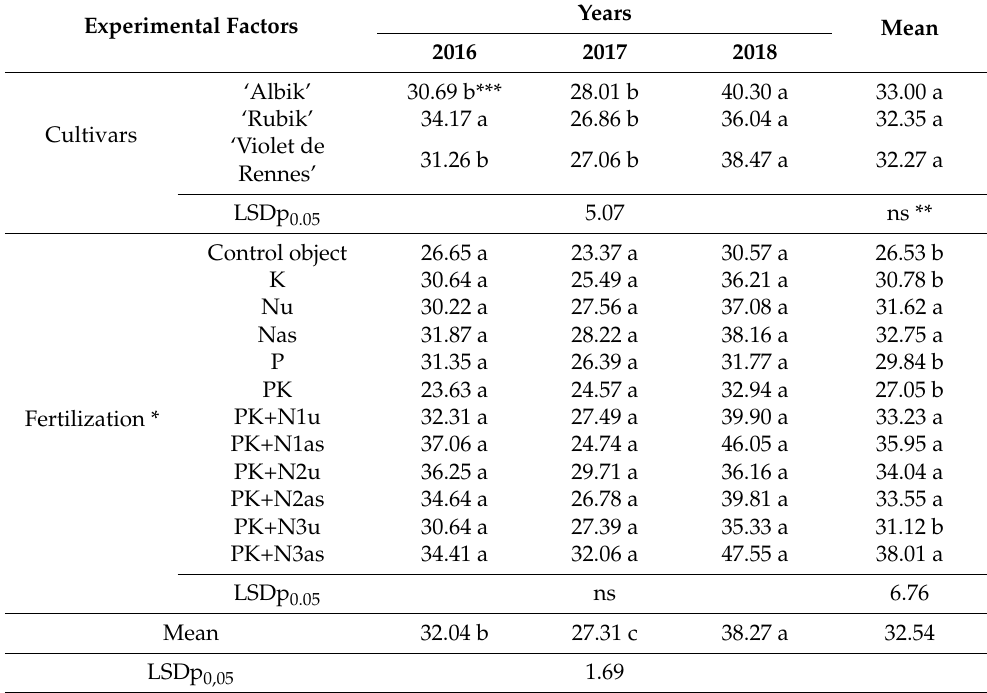
Table 5. Yield of fresh aboveground biomass of JA (Mg · ha − 1